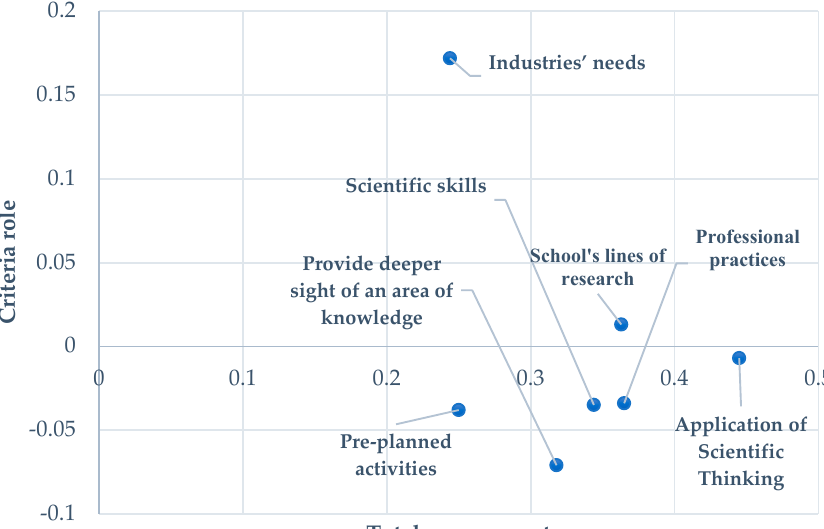
Figure 3. Engagement-position map.